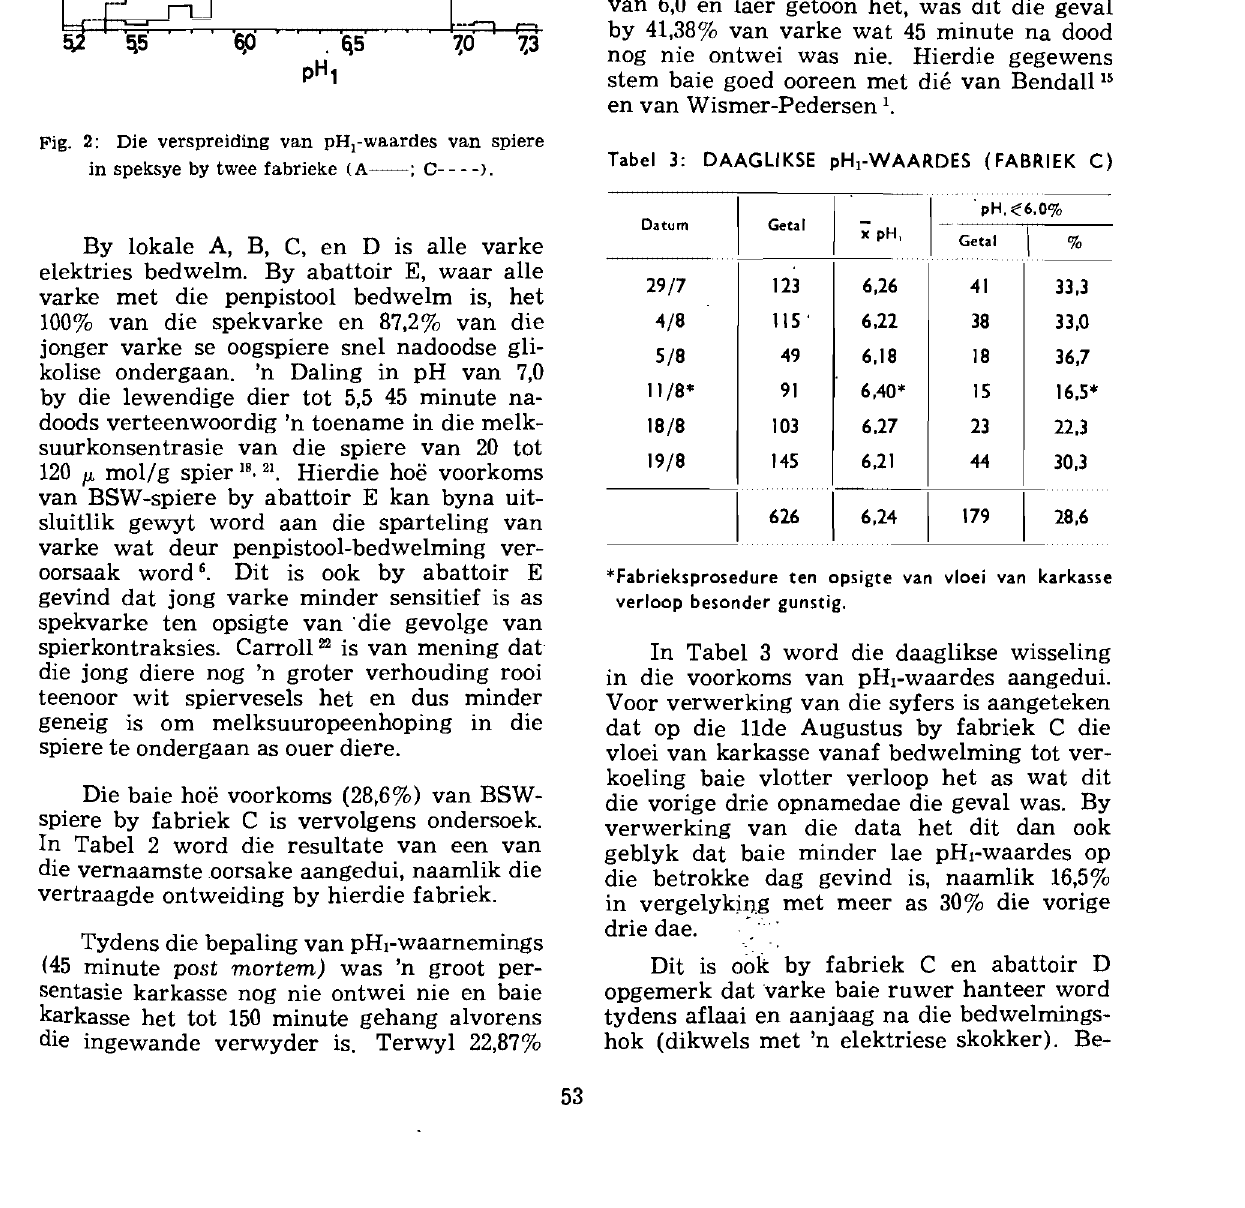
Tabel 3: DAAGLIKSE pHI-WAARDES (FABRIEK C)